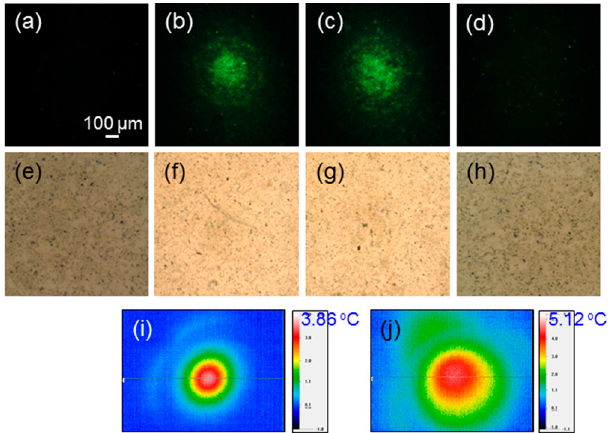
Figure 3. ( a – d ): Fluorescent microscopy images of cells incubated with Au NRIs and green-emitting Lucifer yellow under the conditions of no laser illumination, illuminations of the defocused 1064-nm fs laser for 30 and 60 s, and illumination of the defocused, lower-power 1064-nm cw laser for 10 min, respectively, under the post-washout condition. ( e – h ): Trypan-blue-stained cell images around the laser illumination spots 4 h after laser illuminations corresponding to parts ( a – d ), respectively. ( i , j ): Temperature-change mapping images in the perforation (30-s illumination) and preheating processes, respectively, under the post-washout condition. The shown numbers in °C indicate the maximum temperature changes under individual conditions.